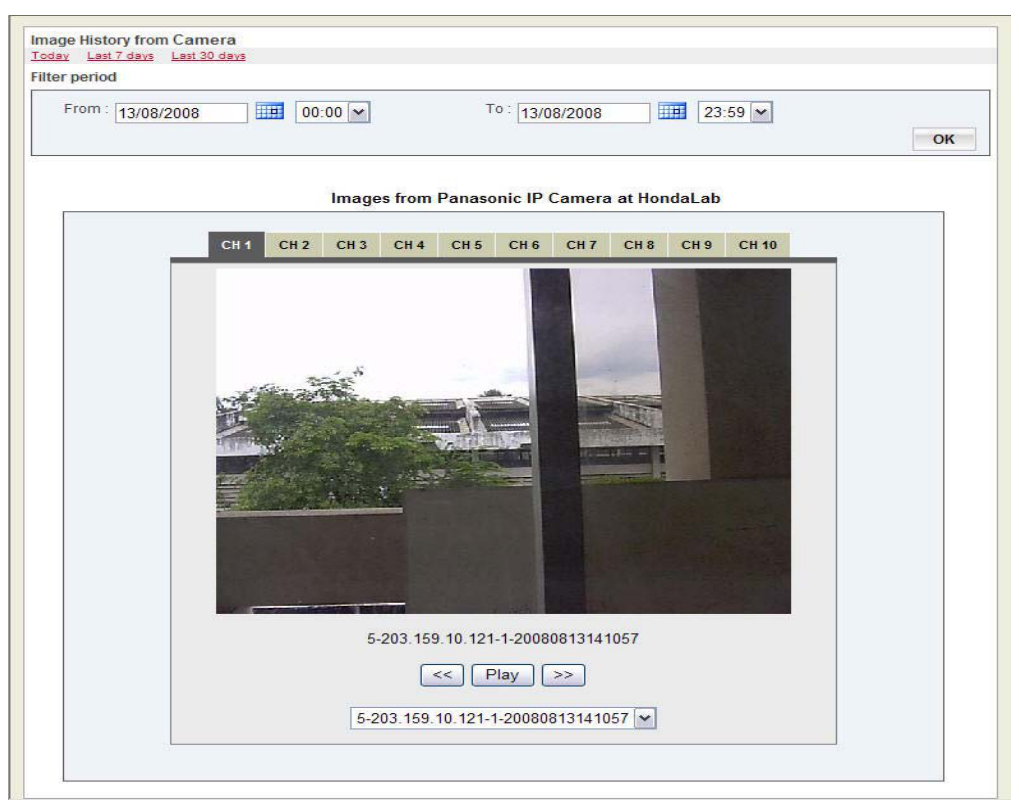
Figure 7. Camera interface of Sensor Asia